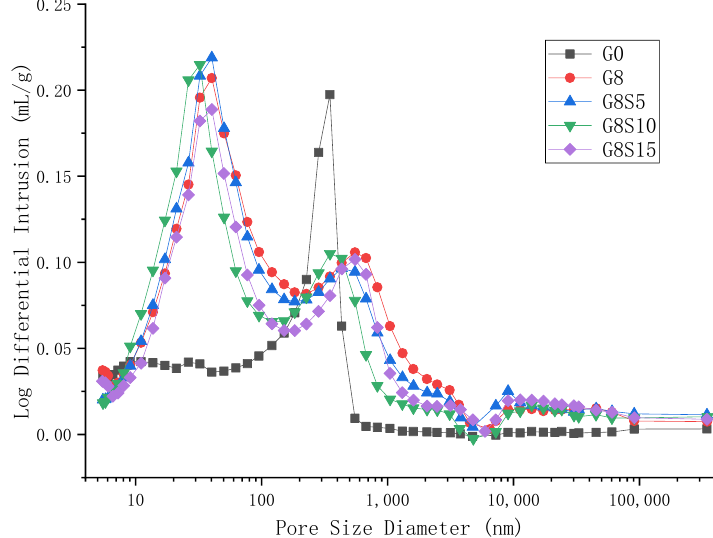
Figure 8. Pore size distribution of sample G0, G8, G8S5, G8S10 and G8S15.